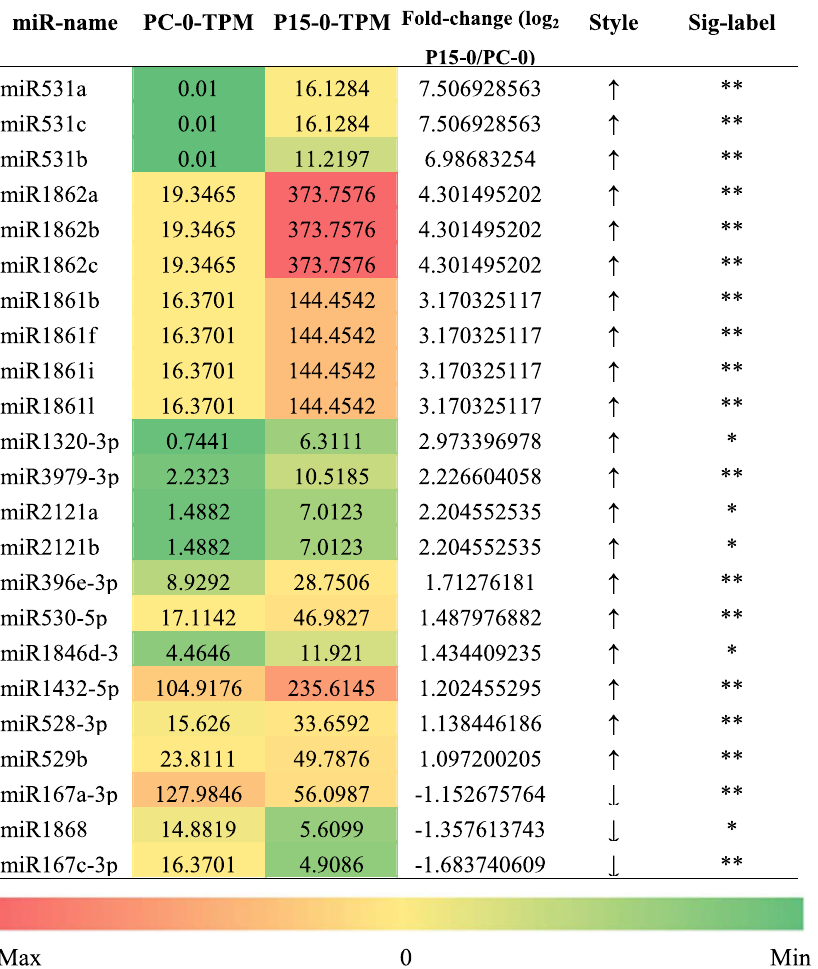
Table 2. Differentially expressed miRNAs in P15-0/PC-0. The TPM was normalized miRNA sequence reads. Style “ ↑ ” indicates that the miRNA was up-regulated in P15-0/PC-0, and style “ ↓ ” indicates that the miRNA was down-regulated in P15-0/PC-0. Statistical significance was analyzed by Bioconductor edgeR package. Significant differences are indicated by * P < 0.05, ** P <